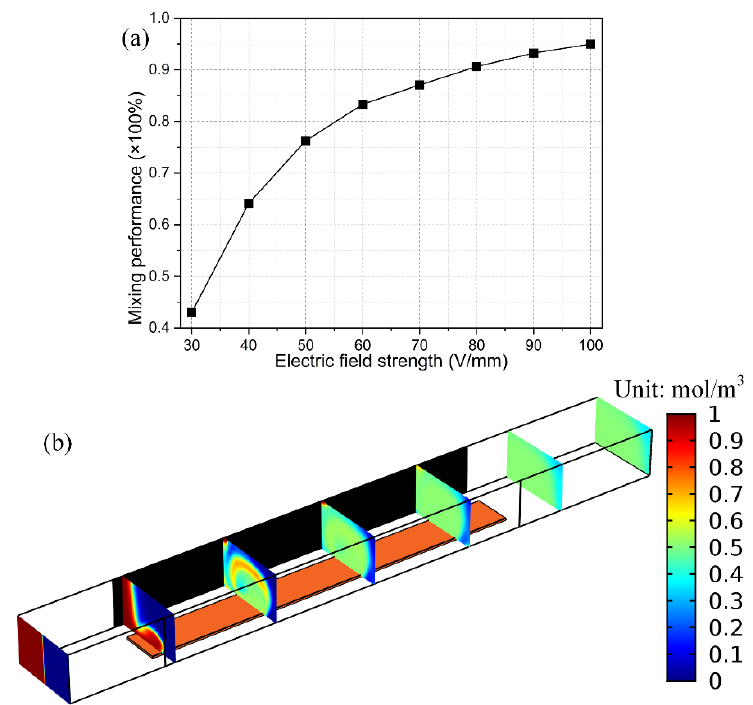
Figure 7. Effect of the imposed voltage magnitude on the device mixing efficiency under given voltage offset ratio 0.625, inlet flow velocity 10 mm/s, and field frequency 100 Hz. ( a ) Voltage-dependence of the mixing performance; ( b ) High-throughput mixing at V D = 20 V and V G = 3.75 V, while there is still a dead zone of ICEO turbulence on the upper right of the channel cross section.